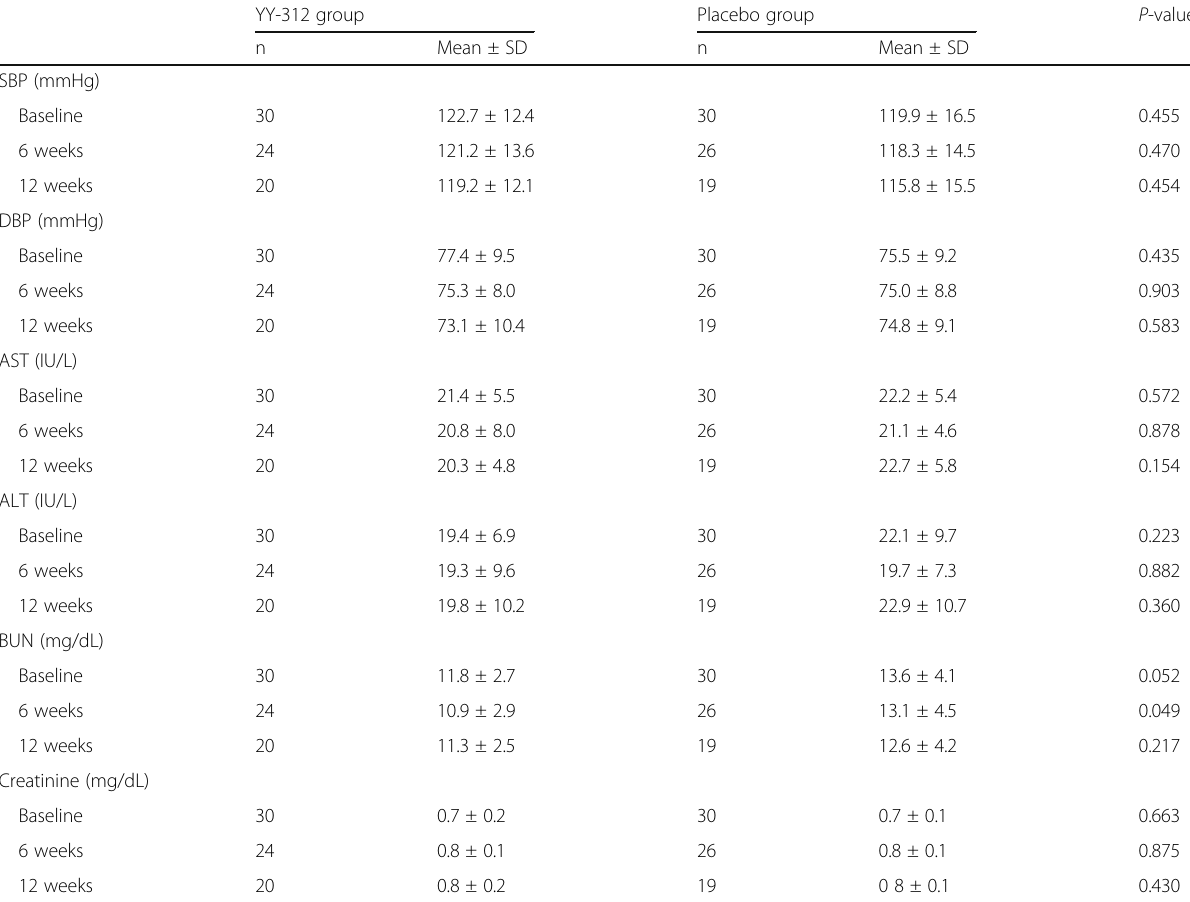
Table 5 Safety outcome variables by group and visit YY-312 group Placebo group P